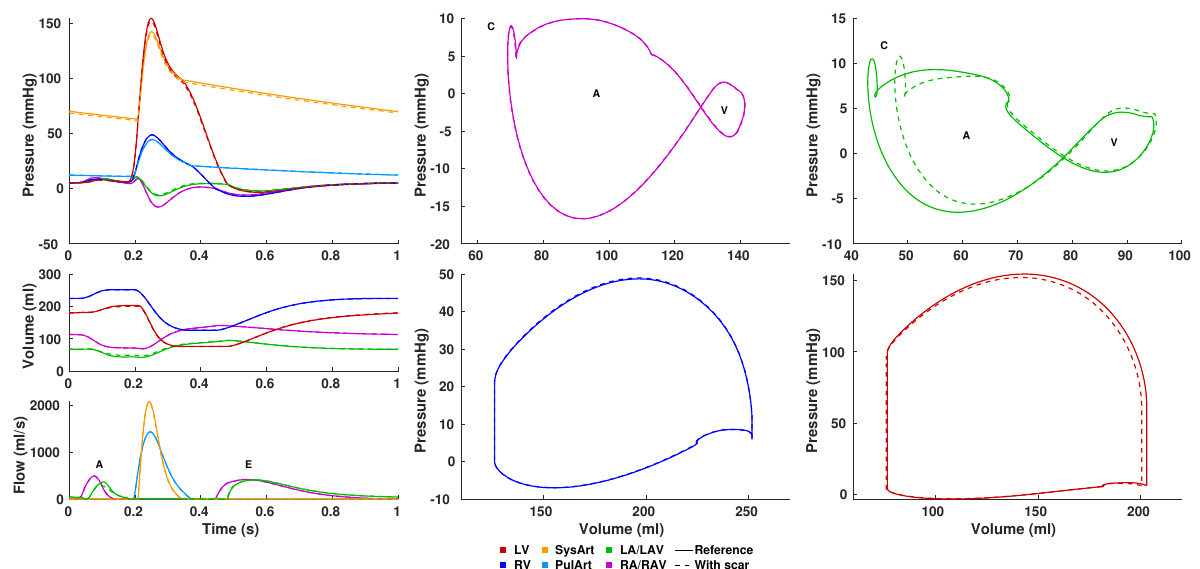
Figure 10. Results of the circulatory system for the reference simulation (solid line) and the simulation with an ablation scar in the left atrium (dashed line) after reaching a stable limit cycle. First column from top to bottom: (1) Wiggers diagram showing pressure with respect to time; (2) cavity volume with respect to time; (3) flow through mitral valve (LAV), tricuspid valve (RAV), systemic arterial flow (SysArt), and pulmonary arterial flow (PulArt). The second and third column show the phase diagrams of the pressure-volume relationship for the left atrium (LA), left ventricle (LV), right atrium (RA), and right ventricle (RV).